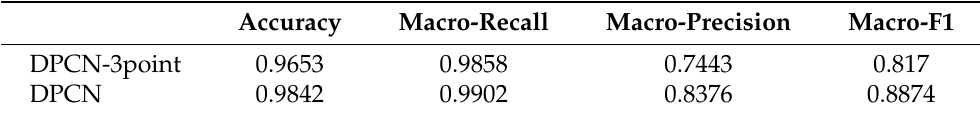
Table 2. The results of the sensitivity analysis of the candidate convolution